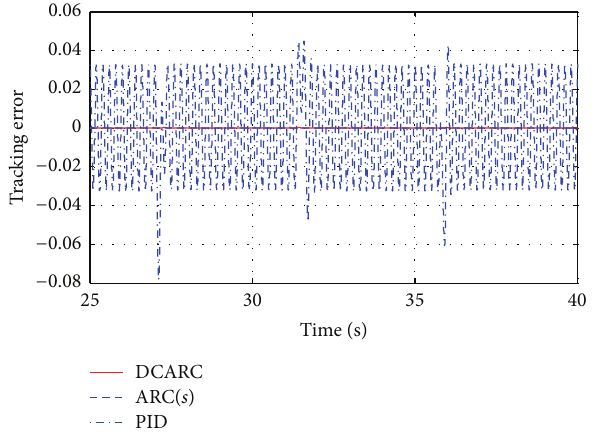
Figure 11: Tracking errors in point to point motion in the presence of parametric uncertainty and uncertain